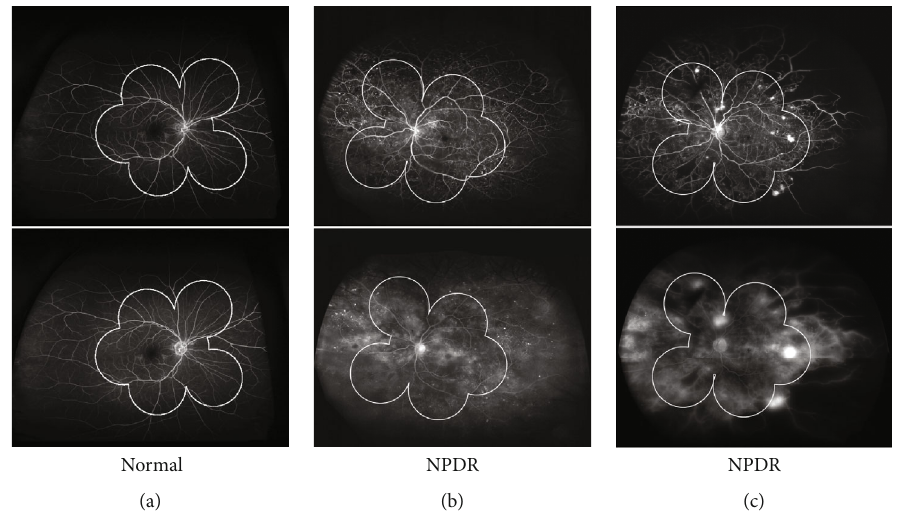
Figure 3: Comparison of the UWFA and simulated 7-SF. (a) UWFA showed wider retina than simulated 7-SF in the normal eye. (b) UWFA image on the early phase showed more nonperfusion in the peripheral retina than simulated 7-SF in the NPDR eye (upper), and more peripheral leakage was found on UWFA image than simulated 7-SF on the late phase (bottom). (c) UWFA image on the early phase showed more nonperfusion and neovascularization in the peripheral retina than simulated 7-SF in the PDR eye (top), and more peripheral leakage was found on UWFA image than simulated 7-SF on the late phase